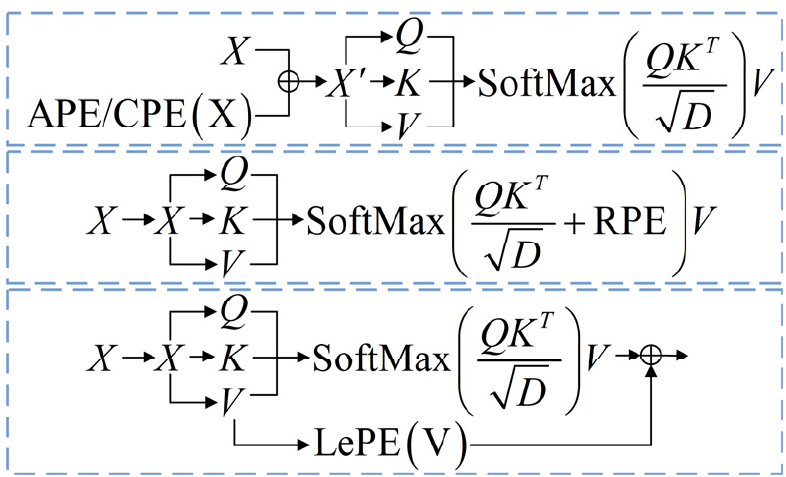
Figure 6. Comparison among different positional encoding mechanisms.